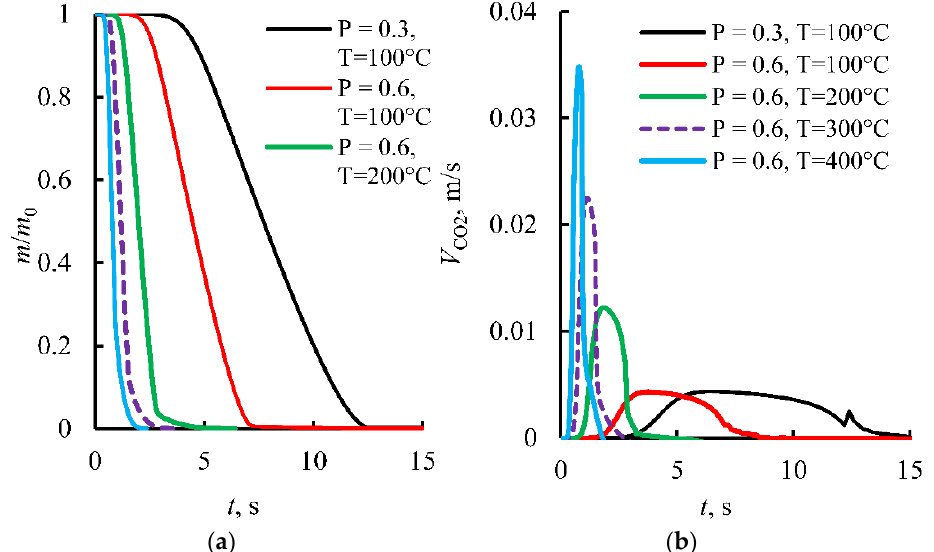
Figure 19. ( a ) Dissociation of CO 2 hydrate powder with varying tablet porosity P and ambient gas temperature T ( m 0 is the initial mass of gas hydrate; the spherical granule diameter is 3 mm). ( b ) Carbon dioxide release rate during the dissociation with varying P and T .